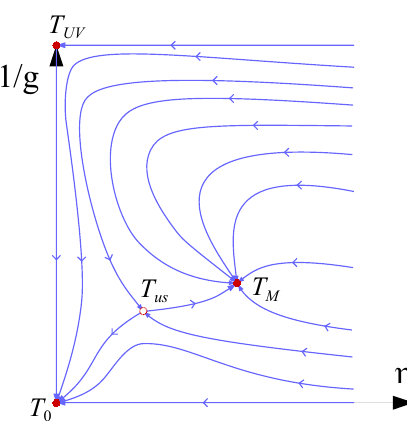
Figure 3 . Qualitative RG diagram of the supposed minimal (cid:13)ow that can accommodate T 0 and T M in cases that W mon is irrelevant in T 0 . Here g is the gauge coupling and (cid:17) the monopole coupling in (cid:17) W mon . The point T UV is the weakly-coupled U( N c ) SQCD with N f (cid:13)avors, T 0 is its IR (cid:12)xed point, and T M the non-trivial (cid:12)xed point with monopole deformation turned on. The topology requires the existence of (at least) one unstable (cid:12)xed point T us